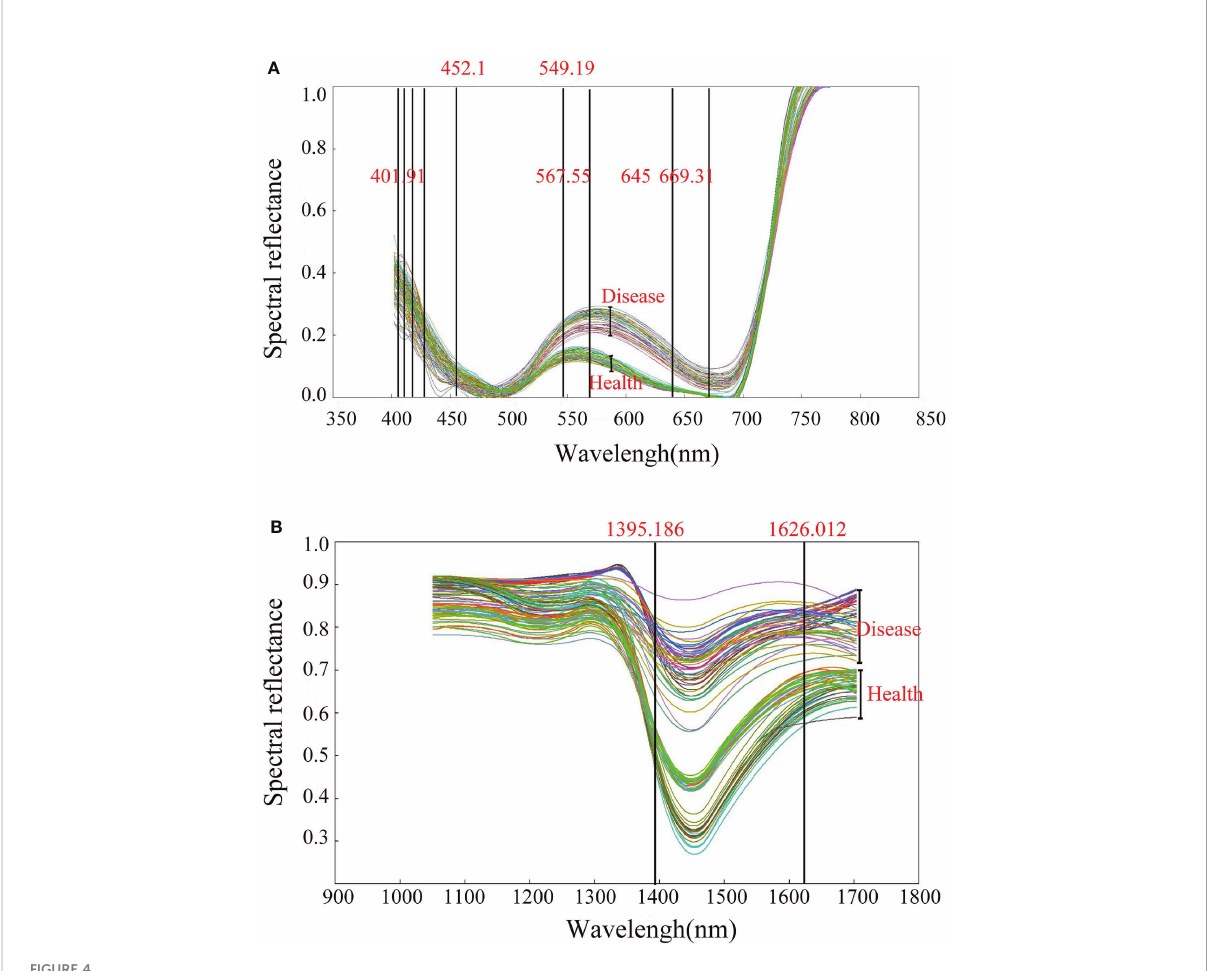
FIGURE 4 Feature wavelength distribution. (A) Visible light. (B) Near